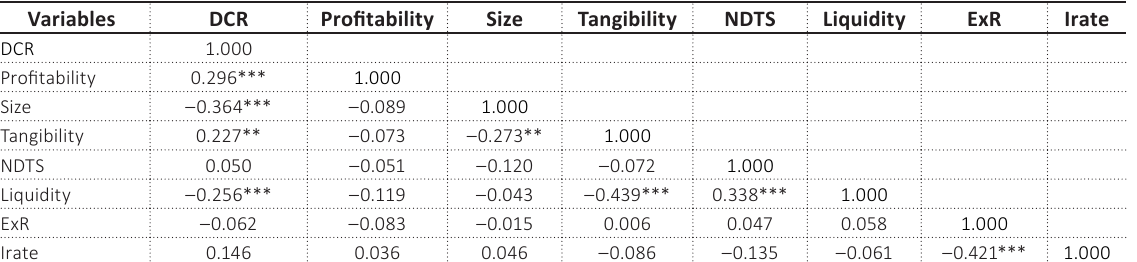
Table 3. Correlation